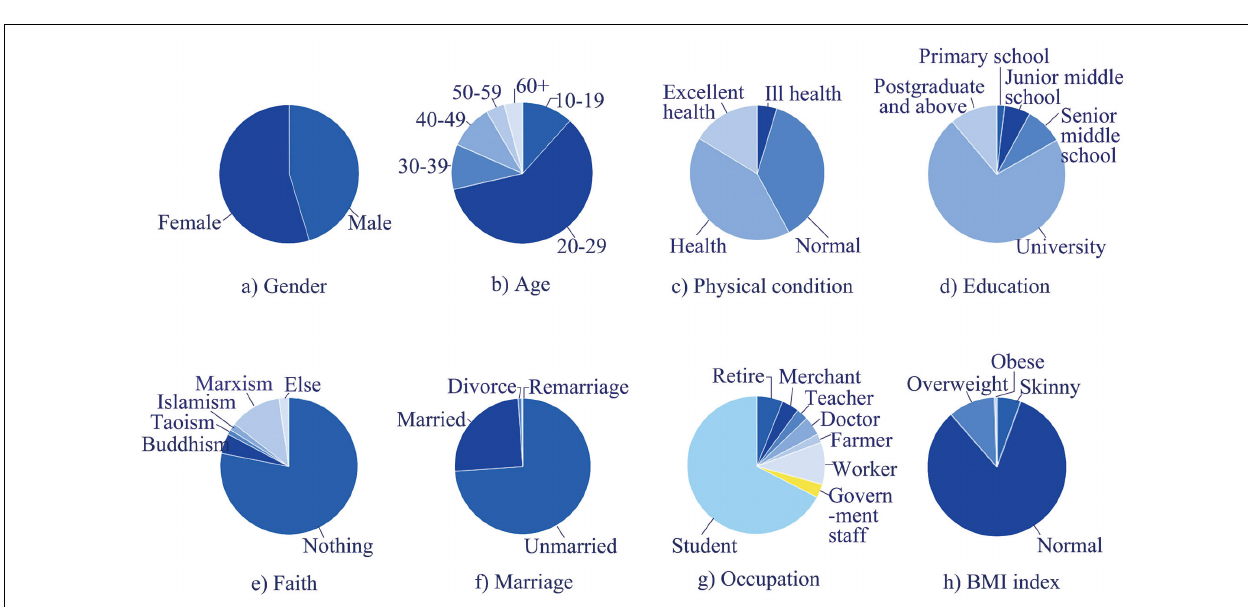
FIGURE 2 | Survey area and quantity distribution.